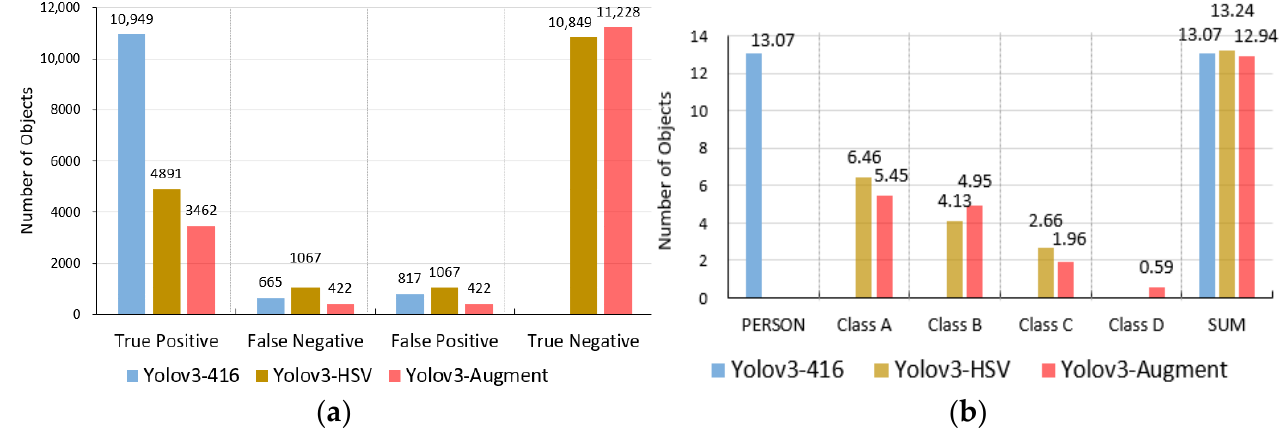
Figure 16. Summation of objects recognition ( a ) Total object recognition; ( b ) Average recognition.